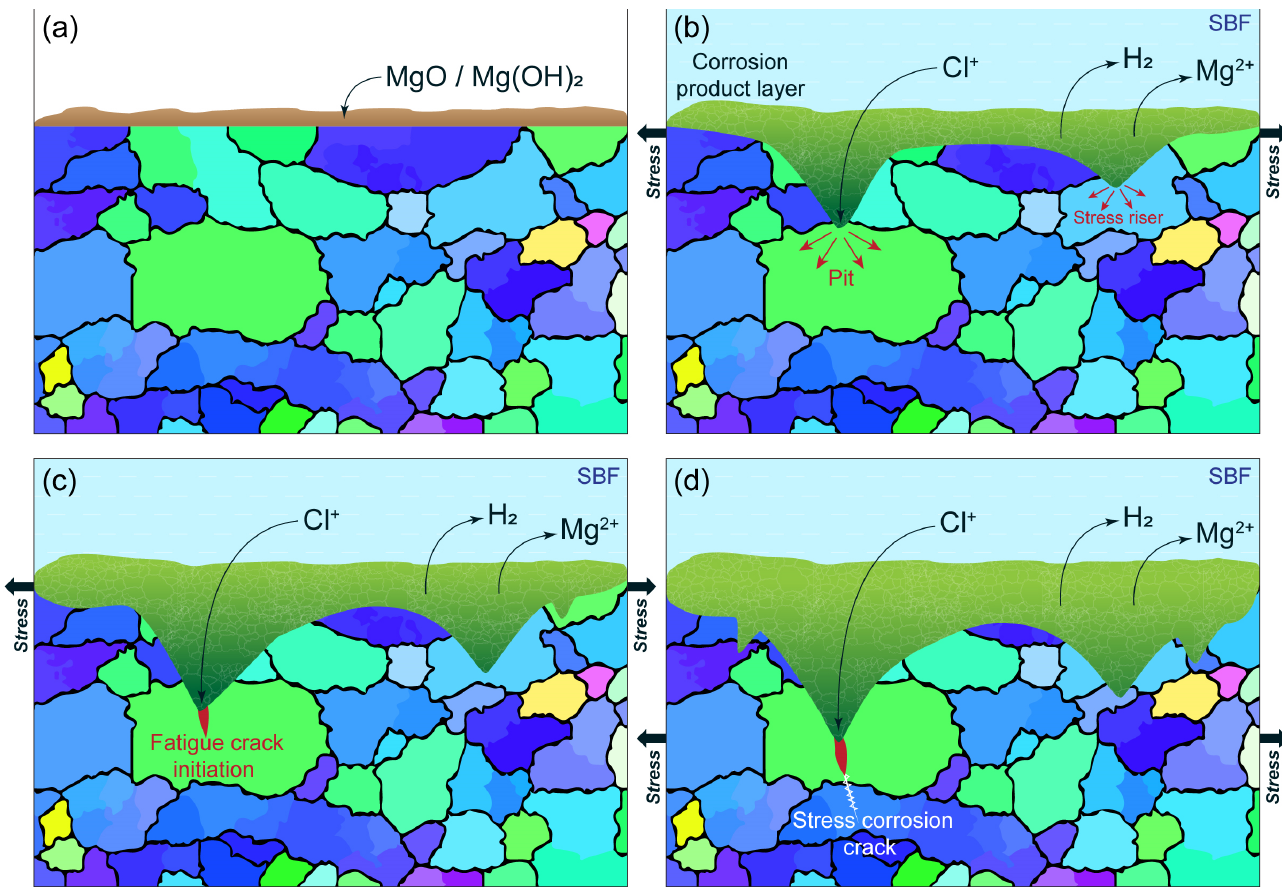
Figure 13. A simplified schematic illustration of the corrosion fatigue-induced damage propagation [231]. ( a ) Initial state with the MgO/Mg(OH) 2 protective film on the surface; ( b ) advanced stage of the corrosion process under stress – the protective film is broken, resulting in the nucleation and growth of corrosion pits and the formation of corrosion product layer; ( c ) initiation of the fatigue crack at the stress concentrator created by the notch-like root of the corrosion pit; ( d ) stress corrosion cracking initiated at the sharp tip of the fatigue crack.